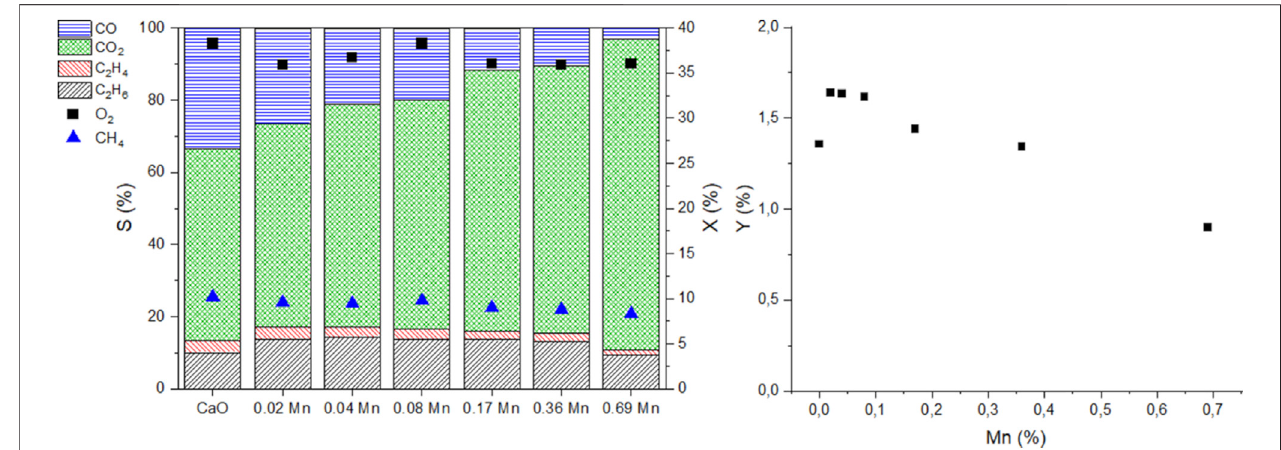
FIGURE10| ComparisonofcatalyticperformanceofMn-dopedCaOcatalystsat750 ° CatsimilarO 2 conversions(leftgraph,leftaxisselectivitiesofproducts,right axis CH 4 and O 2 conversion), respective C 2 yield vs. the Mn content (right, 50 mg carbonate precursor, 750 mg SiC, GHSV can be different by a factor of 5).